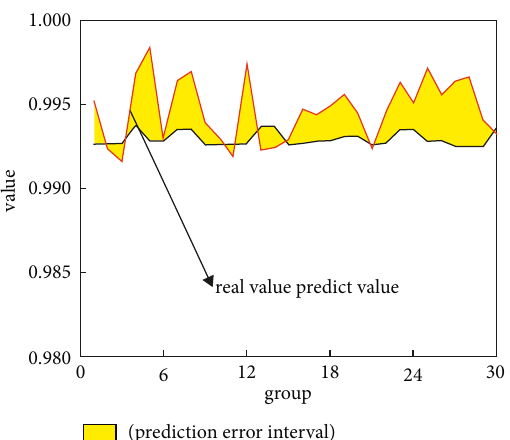
Figure 6: The distribution of predicted and actual values of popular music.